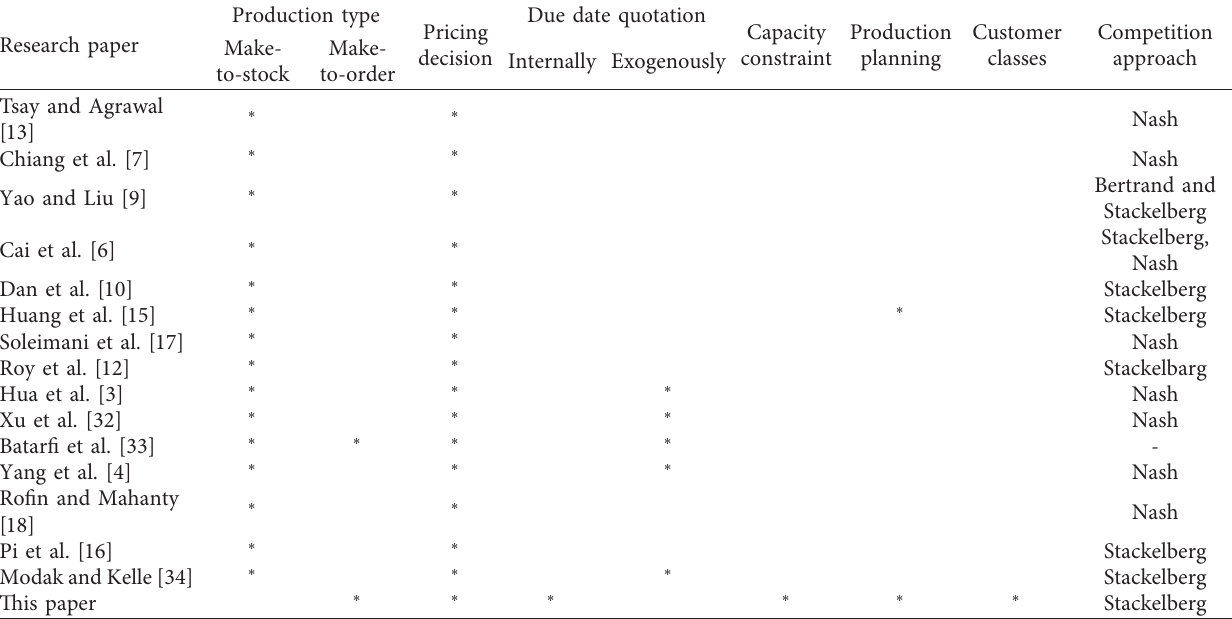
Table 1: Related